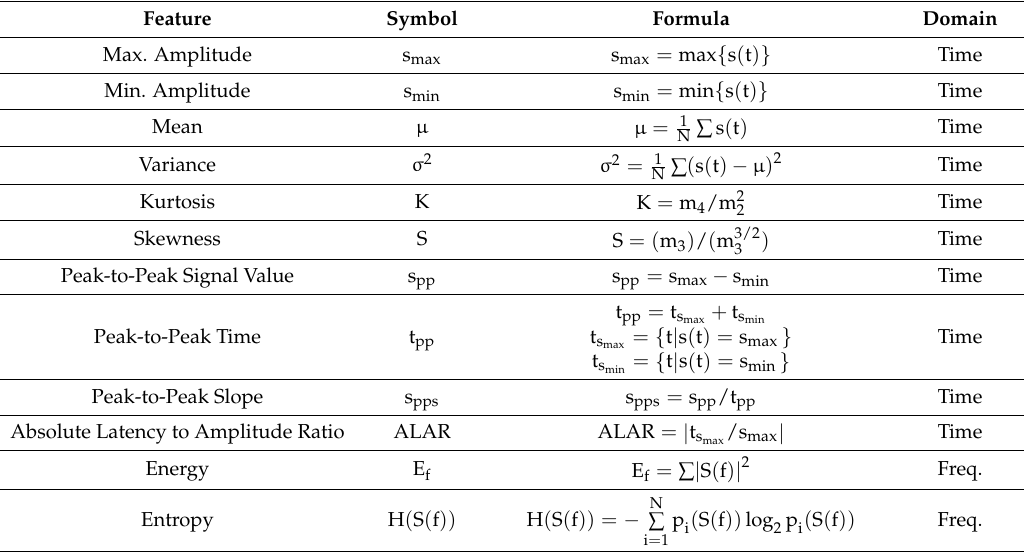
Table 3. A set of features extracted for activity recognition and user